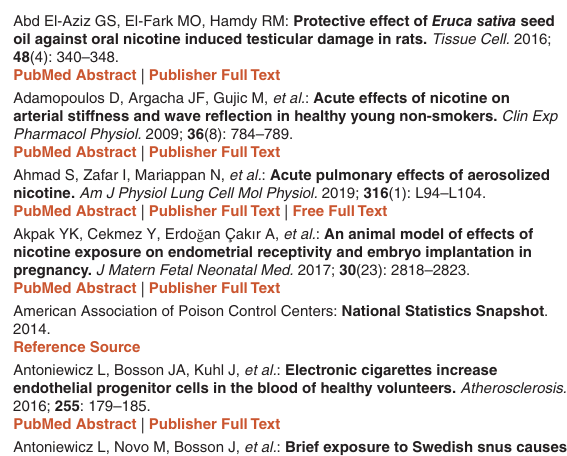
Figshare: Extended Data - Biological Effects of Nicotine Exposure: A narrative review of the scientific